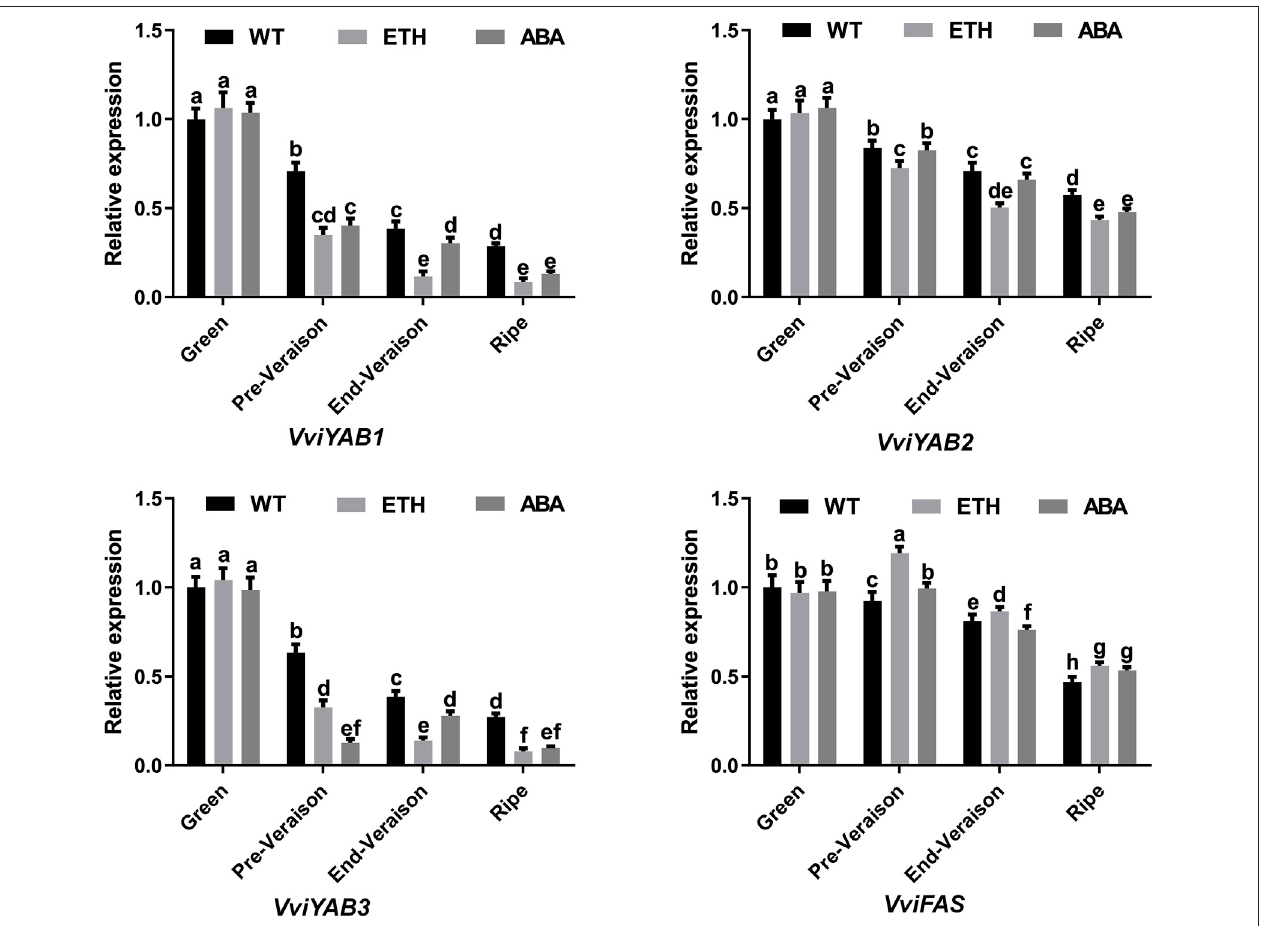
FIGURE6| Expressionpro fi lesof VviYAB genesinresponsetoABAandethylenetreatments.Transcriptswerenormalizedtotheexpressionofthe actin gene.The data are shown as means ± SD of three replicates.